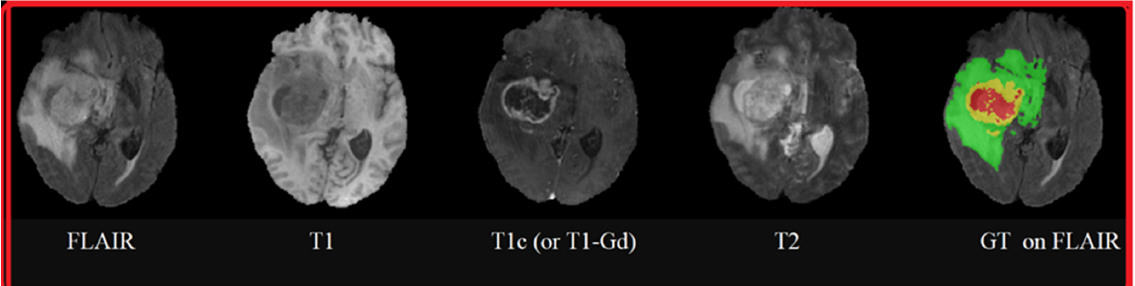
Figure 4. MRI sequences of brain tumors: FLAIR, T1, T1 contrasted by Gadolinium injection, T2, and Ground Truth superimposed on the FLAIR sequence. Ground Truth superimposed on the FLAIR